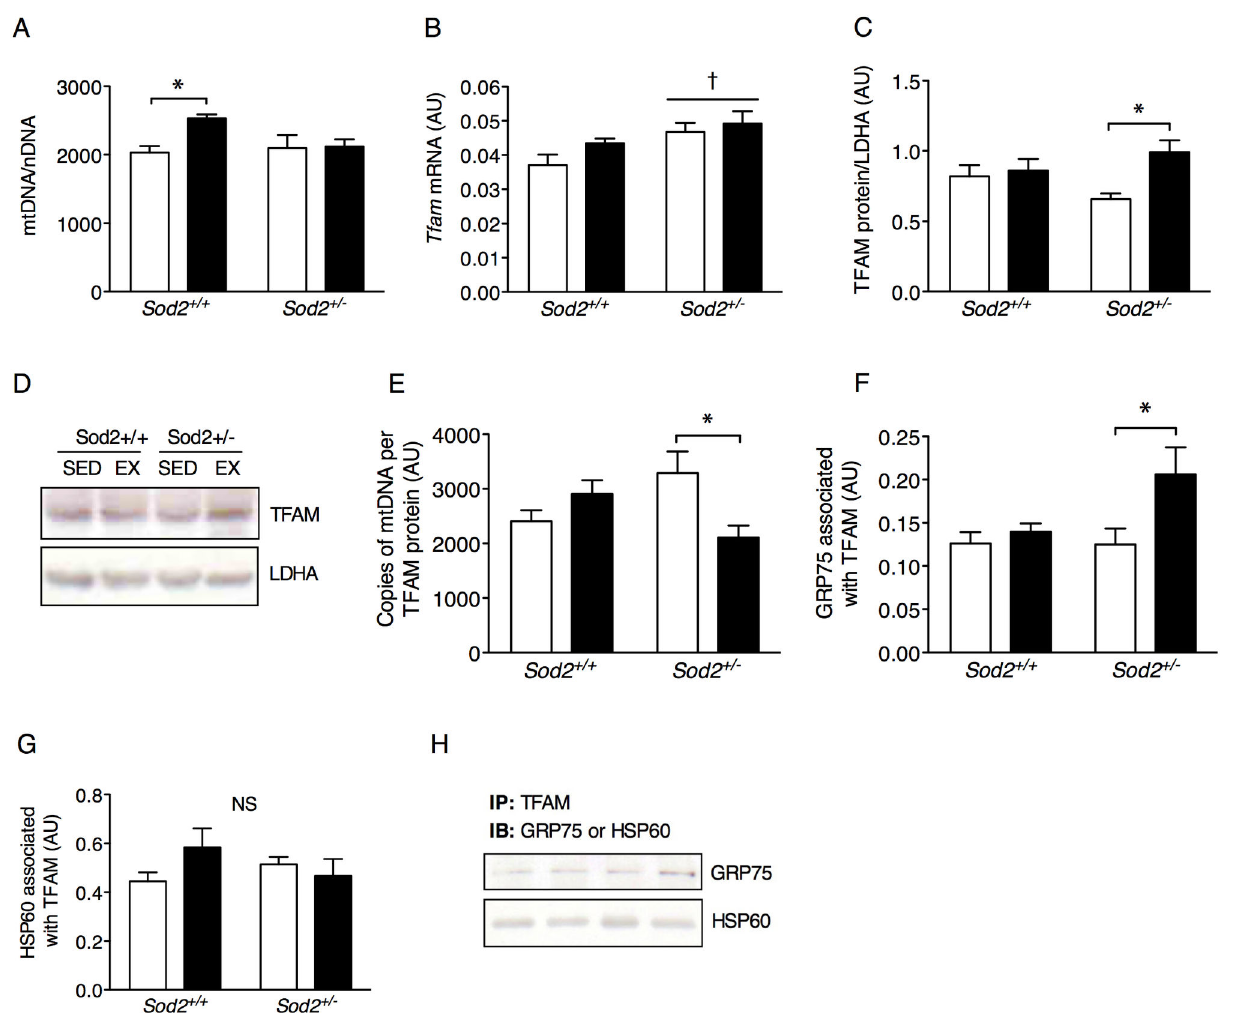
Figure 4. mtDNA transcription is disrupted by oxidative stress due to impaired TFAM function. (A) Mitochondrial DNA copy number in tibialis anterior muscle relative to copies of genomic DNA (mtDNA/nDNA; n = 8-10). (B) Tfam mRNA expression using β2-microglobulin as the housekeeping gene in quadriceps femoris muscle, (C) TFAM protein content relative to LDHA in tibialis anterior muscle and (D) representative immunoblots ( n = 8-10). (E) Copies of mtDNA expressed relative to TFAM protein ( n = 8-10). (F) GRP75 and (G) HSP60 protein co-immunoprecipitated with TFAM in isolated mitochondria and (H) representative immunoblots for each group ( n = 3, for control experiments see also Figure S3A-C). All data are mean±SE. *Indicates a significant difference ( p < 0.05) from the indicated group(s) as determined by ANOVA. †Indicates a main effect of genotype ( p <